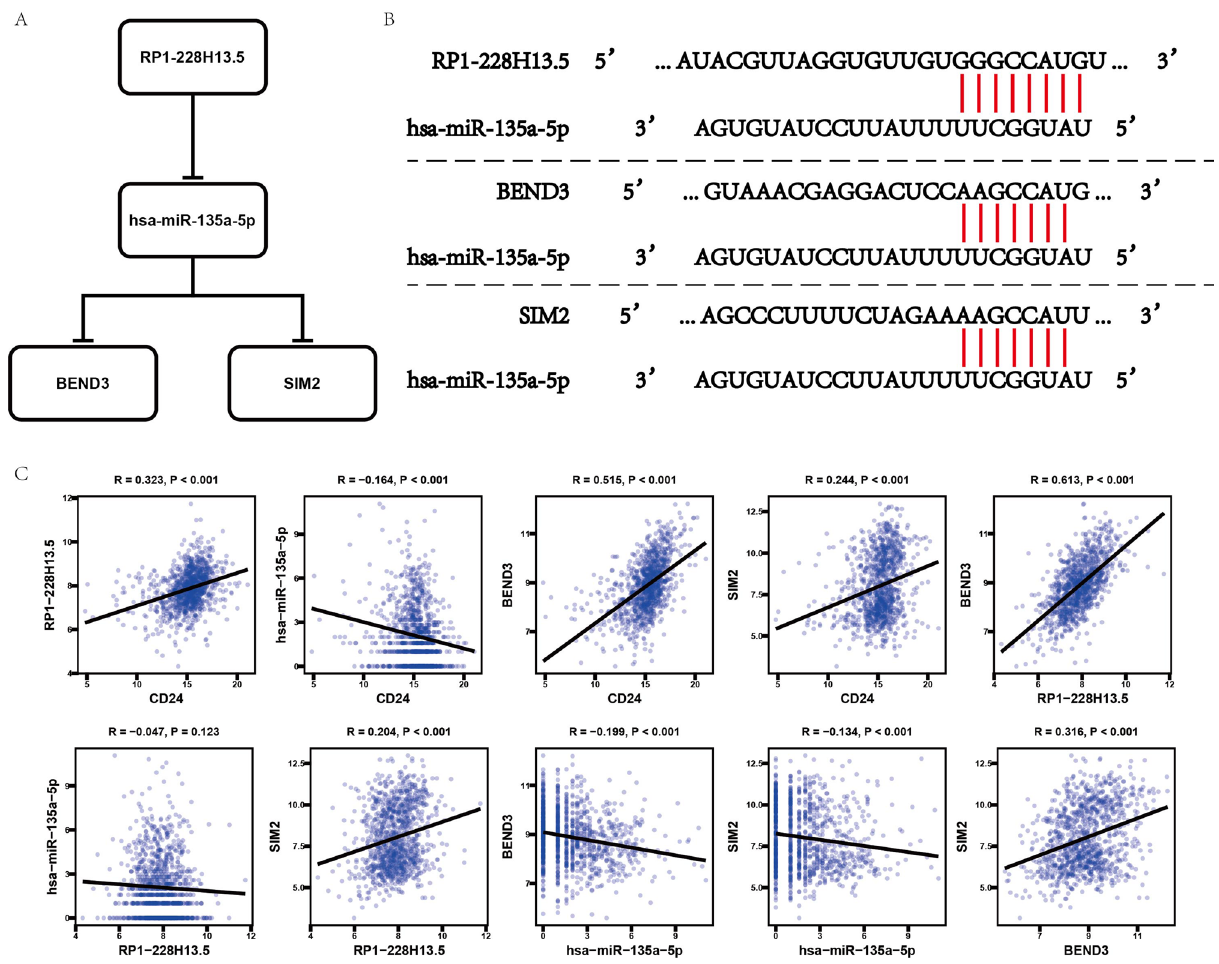
Figure 9. The identification significant ceRNA axis. ( A ) Schematic diagram of significant ceRNA axis. ( B ) The sequence of significant genes in ceRNA network. ( C ) Co-expression analysis of significant genes in ceRNA